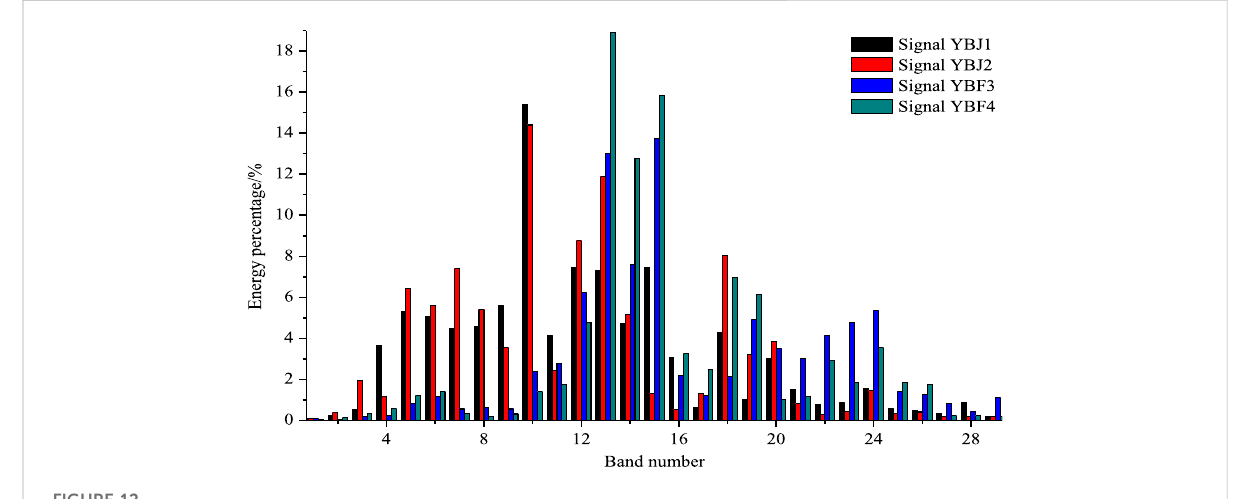
FIGURE 12 The percentage of energy distribution in each frequency band of blasting vibration